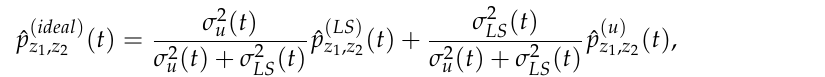
2 and the highest probability